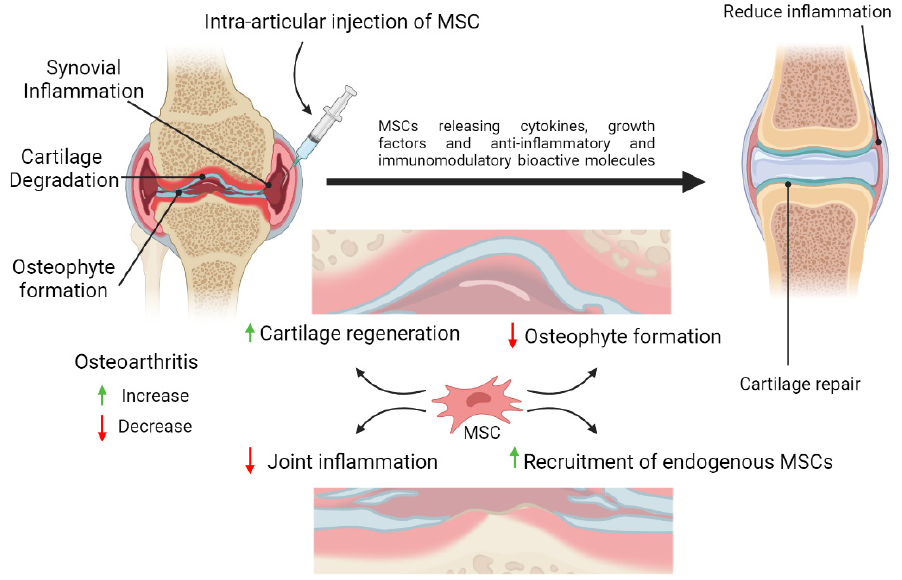
Figure 3. Schematic representation of the potential therapeutic strategies utilizing mesenchymal stem cells (MSCs) therapy for cartilage repair and regeneration. MSCs possess anti-inflammatory and immunomodulatory properties which could reduce inflammation in the joint. MSCs may also assist in the healing process by differentiating into chondrocytes or promoting the proliferation and differentiation of the remaining healthy chondroprogenitors into mature chondrocytes, or both. By releasing trophic factors and cell-to-cell interactions, MSCs may enhance cartilage regeneration and reduce synovial inflammation in the osteoarthritic joint.